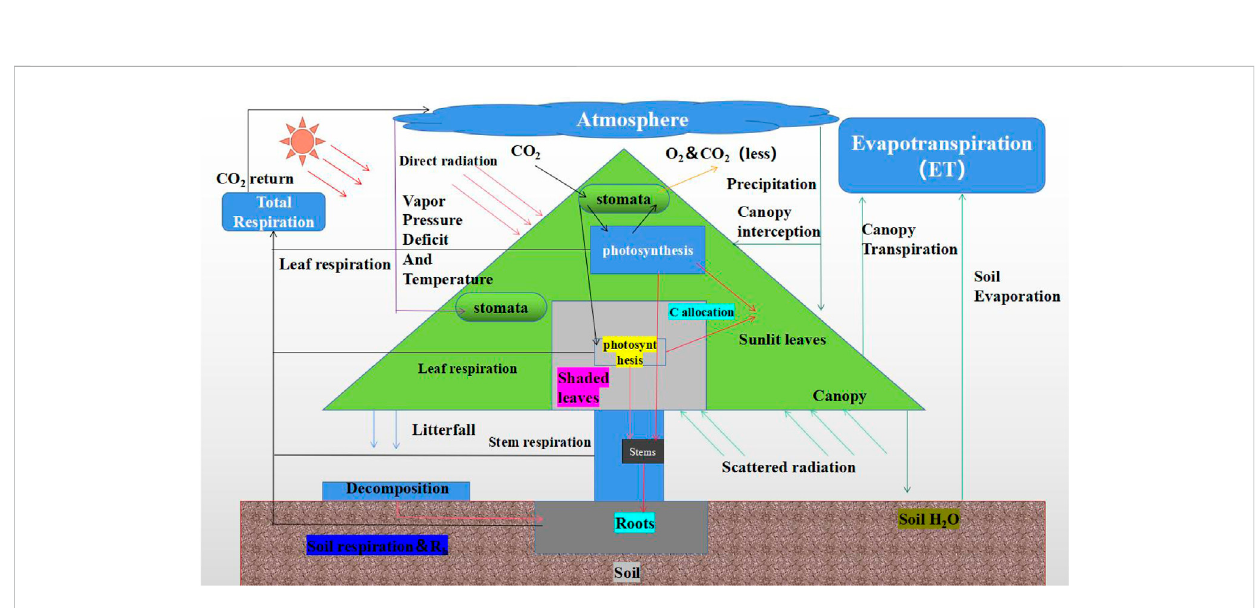
FIGURE 2 Process and mechanism of ecological process